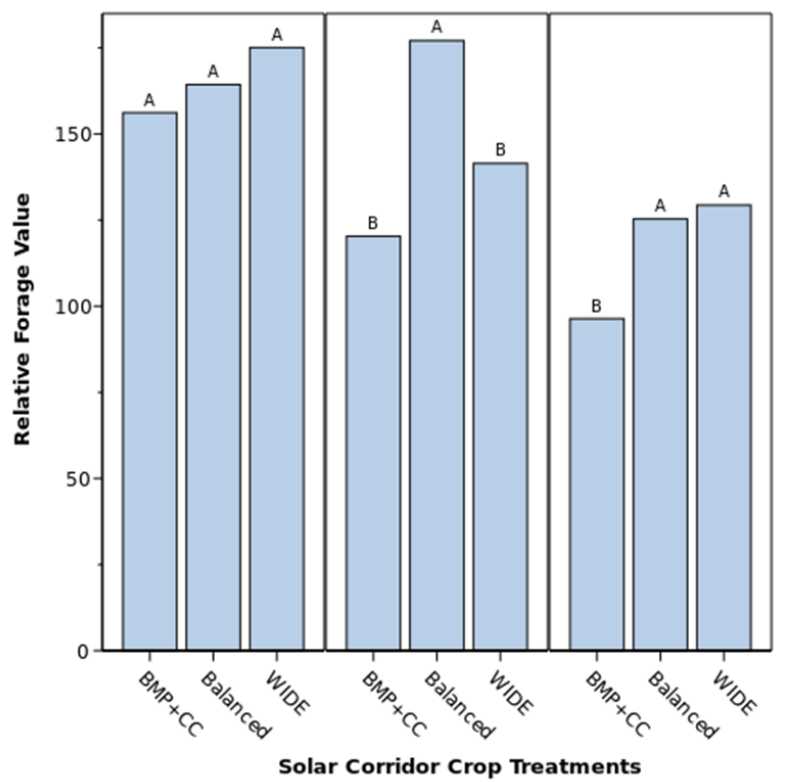
Figure 3. Row treatment and location effect on the relative forage value at Goodhue, MN, USA ( left ), Cherry Grove Township ( center ), MN, USA, and Faribault, MN, USA ( right ). BMP + CC, 76-cm rows with a cover crop; Balanced, 76 cm with a cover crop and two skip rows every fourth row; WIDE, 152-cm rows with a cover crop. All mean separation values were based on Fisher’s protected LSD at α = 0.05.